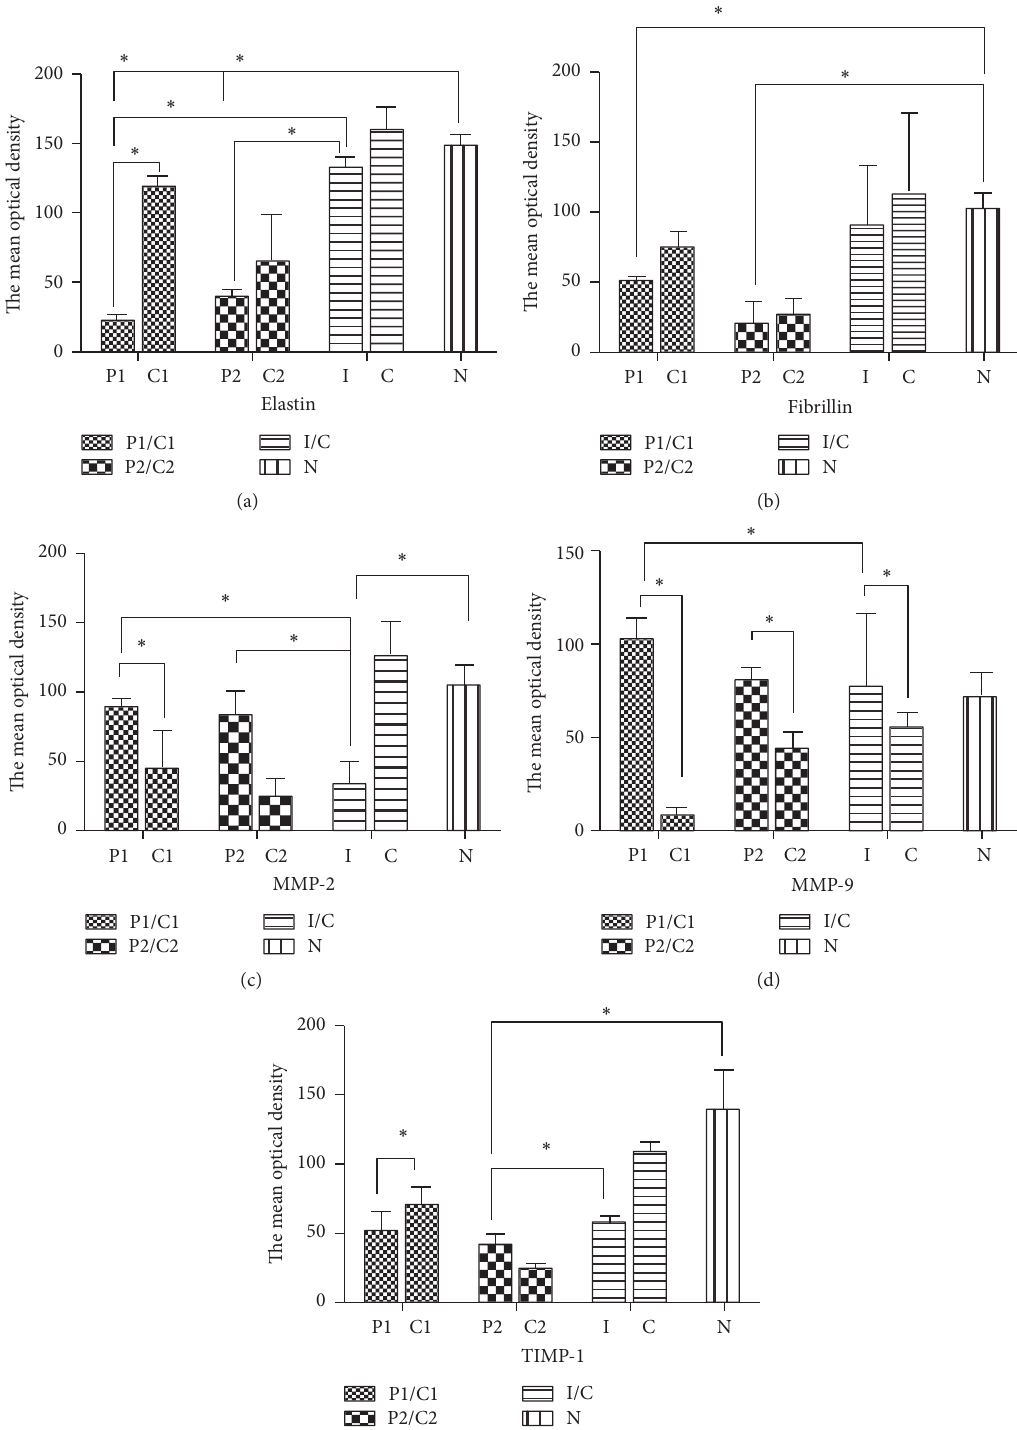
Figure 5: The mean optical density for elastogenesis and degradation markers in the dermis of protruding and indented type anetoderma. (a) Elastin, (b) fibrillin, (c) MMP-2, (d) MMP-9, and (e) TIMP-1 (P1: protruding lesion from case 1, C1: nonlesional control from case 1, P2: protruding lesion from case 2, C2: nonlesional control from case 2, I: indented lesion from case 3, C: nonlesional control from case 3, and N: control from normal patient) ∗ 𝑝 < 0.05: t -test, between two